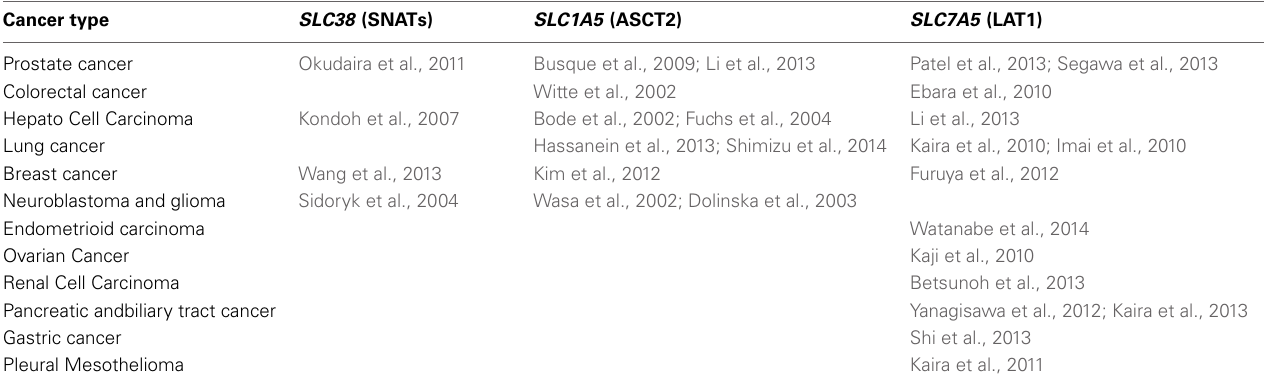
Table 2 | SNATs, ASCT2, and LAT1 associated